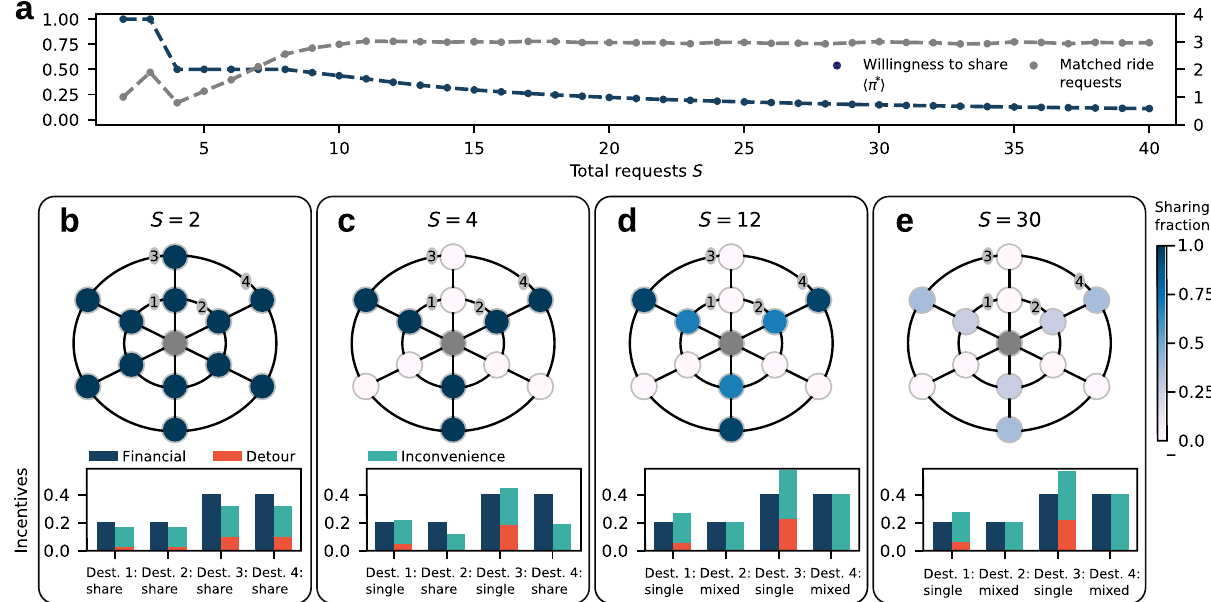
Fig. 3 Adoption of ride-sharing decreases with request rate. In a stylized city topology (panels b – e ) users request transportation from a single origin (gray) to destinations in the city periphery homogeneously (results are robust for alternative settings, see Supplementary Note 4). a The global equilibrium adoption of ride-sharing decreases as the number of users increases (blue) while the number of actually shared rides becomes constant (gray). The kink for S = 3 is an artefact related to the small and odd number of requests and matching of exactly two requests per vehicle such that one request can never be paired (see Supplementary Note 3 for details). b – e As the number of users increases, ride-sharing adoption decreases and a sharing/non-sharing pattern emerges around the origin (top), resulting from the equilibrium incentive balance (bottom, illustrated for the numbered destinations) and possible matching constellations. Requests for shared rides are only matched when traveling to the same or to neighboring branches when the combined trip and return is shorter than the sum of individual trips. With few requests ( S = 2, panel b ), all users request a shared ride. The expected detour and inconvenience is small since it is unlikely to be matched with another user. As the number of users increases ( S = 4, panel c ), half of the destinations stop sharing in an alternating sharing/non-sharing pattern around the origin. In this con fi guration, users requesting a shared ride never suffer any detour while users that do not share are disincentivized from doing so due to their high expected detour (compare bottom part of panel c ). For high numbers of users ( S = 12 and 30, panels d and e ), the probability to be matched with another user when requesting a shared ride increases and the fi nancial incentives cannot fully compensate the expected inconvenience. The adoption of ride-sharing decreases until the fi nancial incentives exactly balance the expected inconvenience (panels d and e , bottom). Illustrated here for fi nancial discount ϵ = 0.2 and inconvenience and detour preferences ζ = 0.3 and ξ =